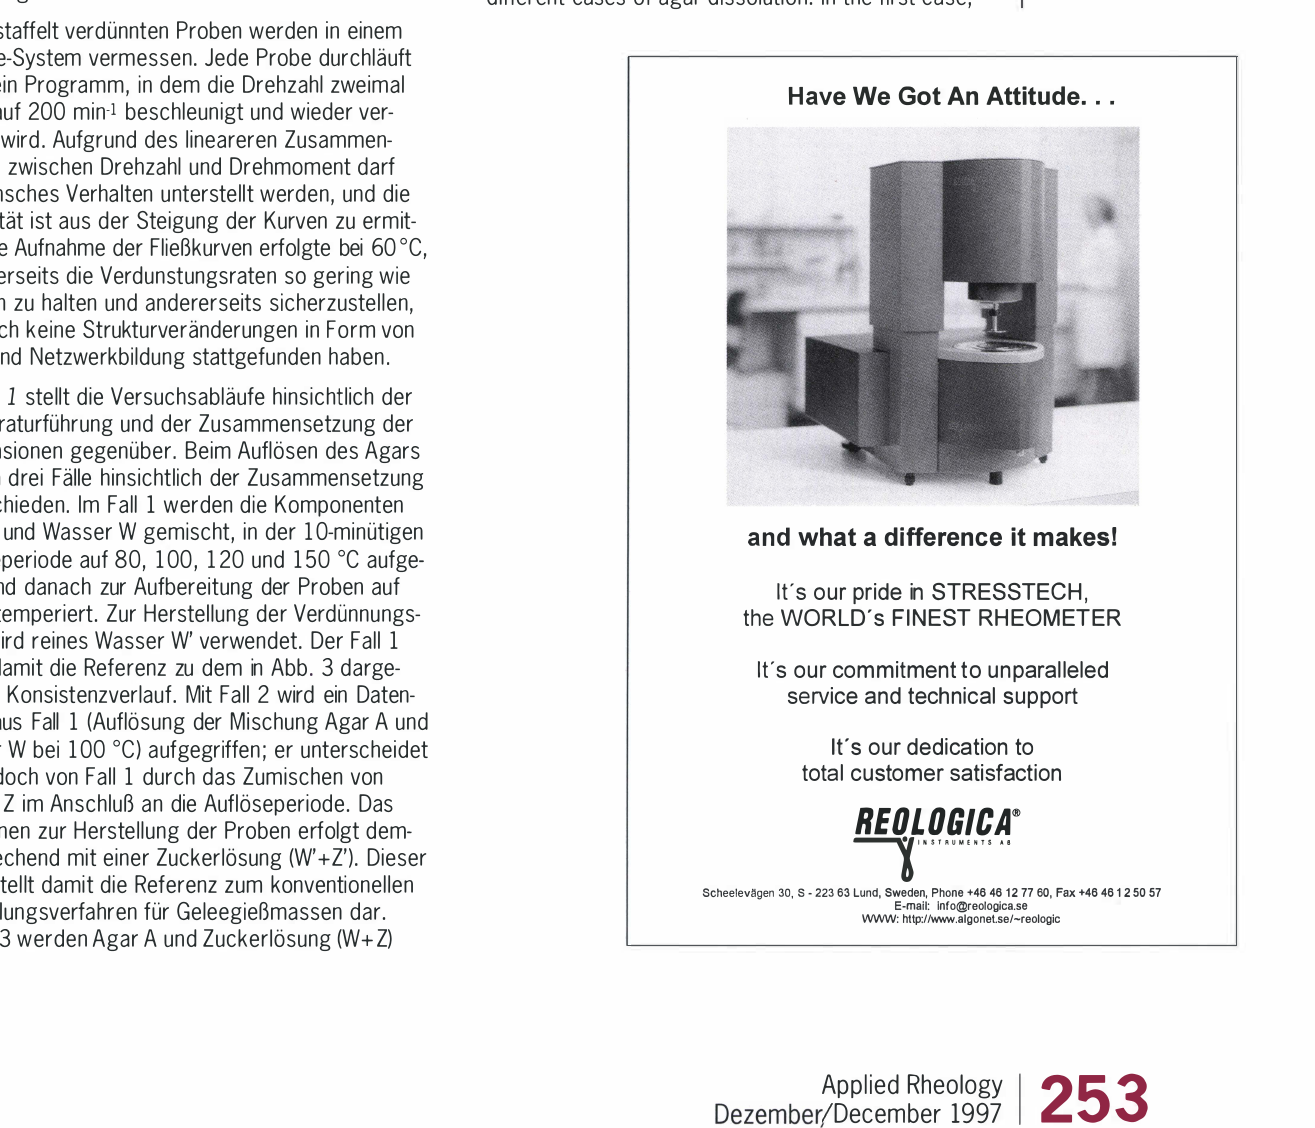
1 shows the experimental conditions in terms of the temperature changes and composition of the suspensions. One can distinguish between three different cases of agar